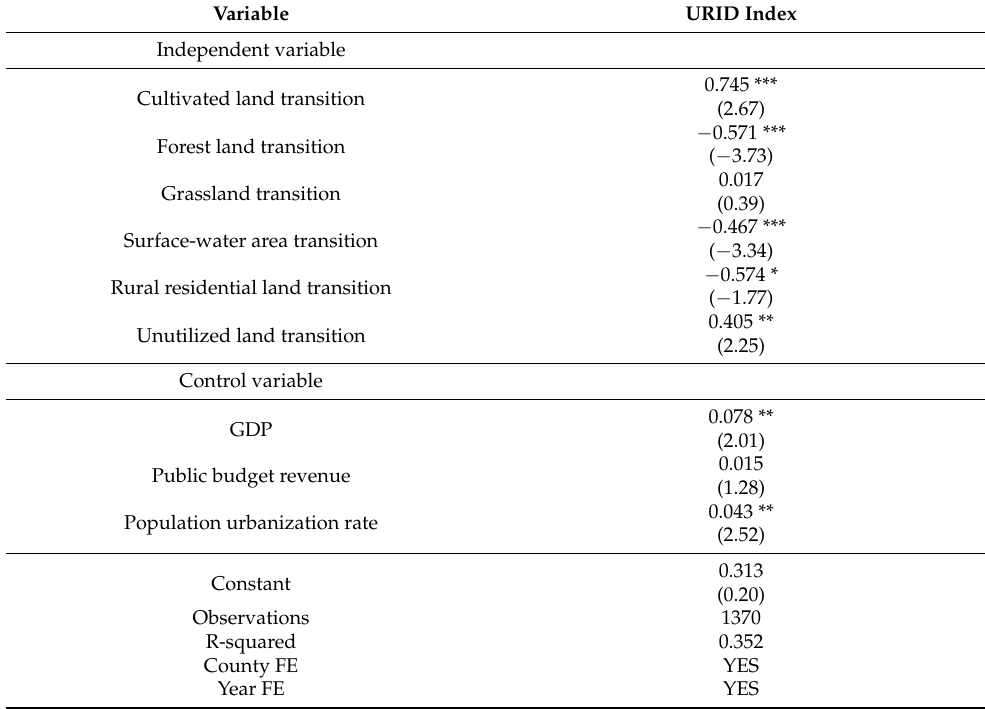
Table 2. Regression